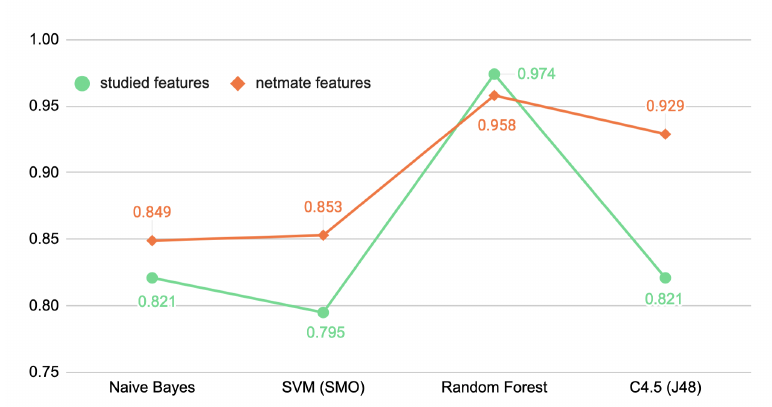
Figure 9. Average recall of the classifiers on both sets of